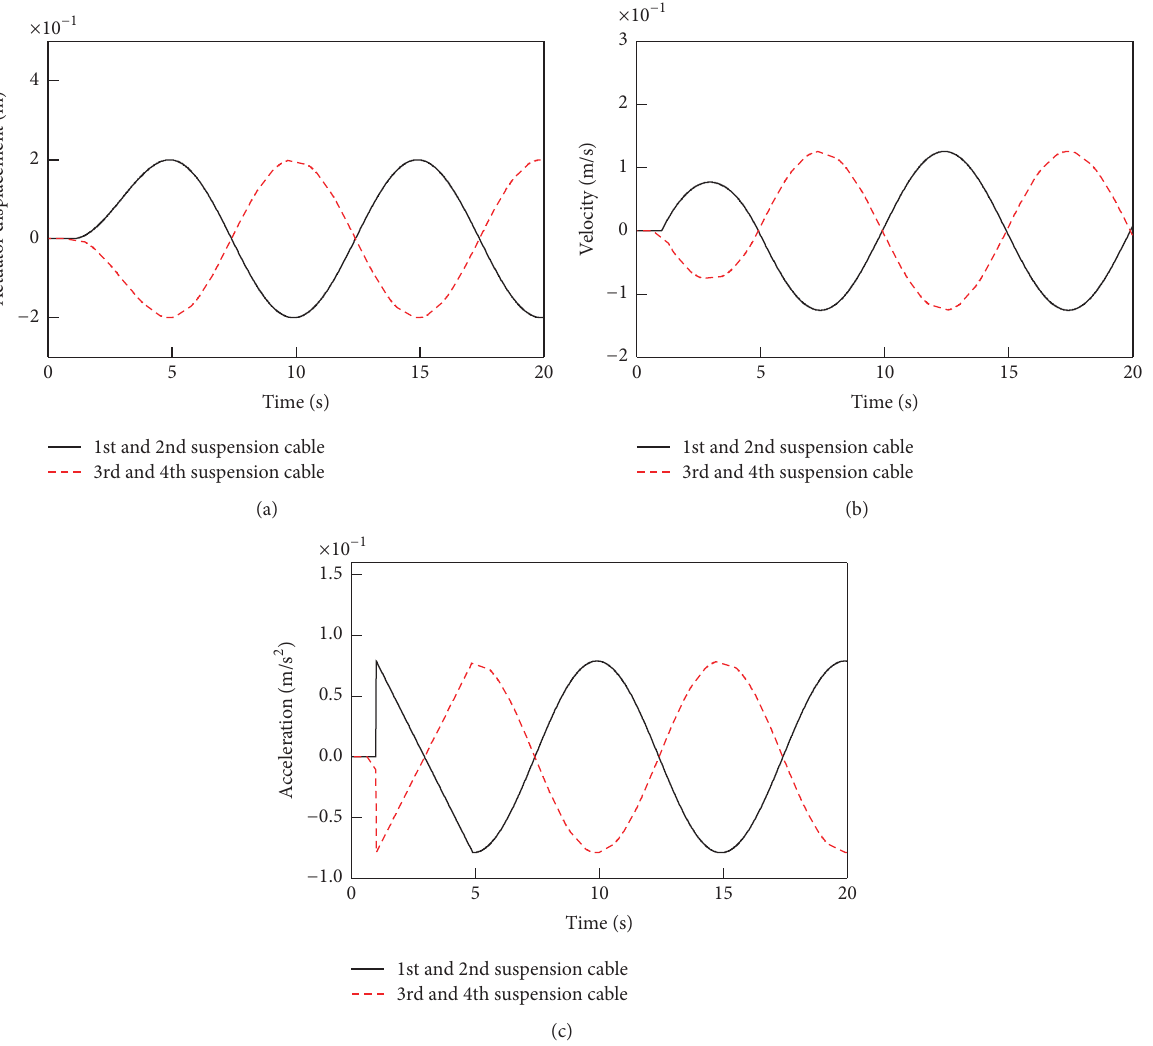
Figure 4: Movement profiles: (a) displacement 𝑙 𝑖 ( t ); (b) velocity V 𝑖 ( t ); (c) acceleration 𝑎 𝑖 ( t